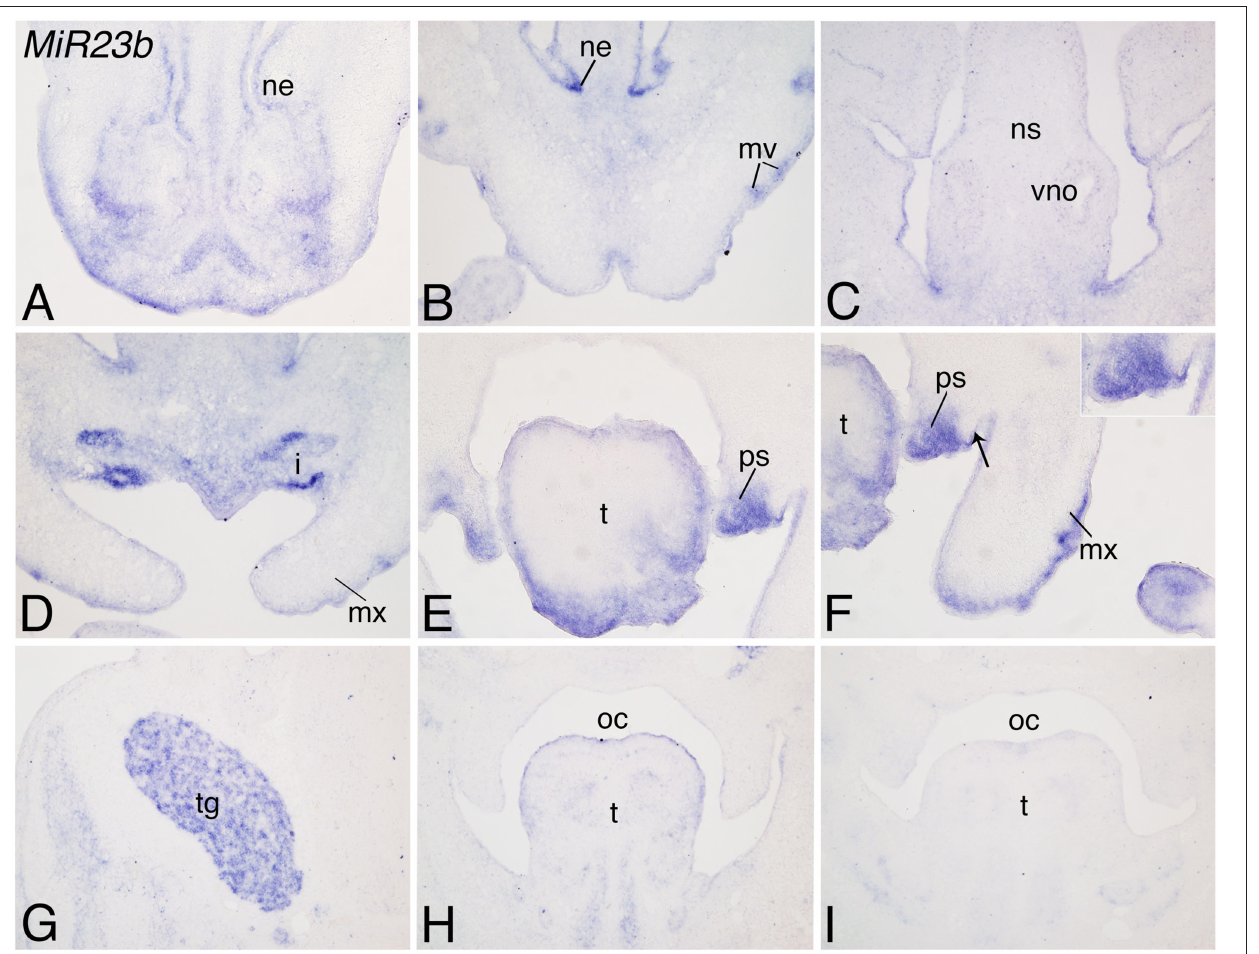
FIGURE 3 | Expression of Mir23b in mouse facial structures at E12.5. ISH analysis in frozen frontal sections through the head of E12.5 mouse embryos. (A–C) Mir23b is moderately expressed in the nasal epithelium epithelium (ne), mystacial vibrissae (mv), nasal septum (ns), and vomeronasal organ (vo). (D–F) Mir23b is also expressed in the upper incisors (i), tongue (t), maxillary epithelium (te), and palatal shelves (ps). The arrow in (F) denotes the epithelium where Mir23b expression begins. (G–I) More posteriorly, expression is observed in the trigeminal ganglion (tg; G ), posterior tongue (t; H,I ). i, incisor; mx, maxilla; oc, oral